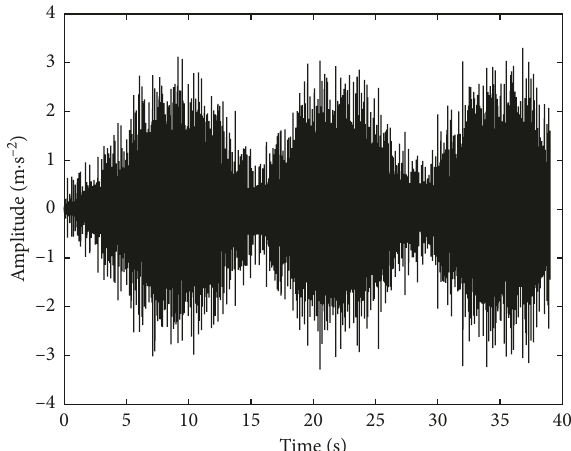
Figure 23: Waveform of rolling bearing vibration.